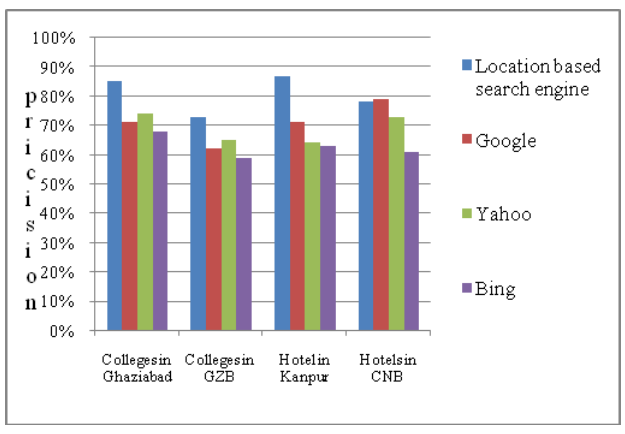
Figure 7. Geo/geo ambiguity